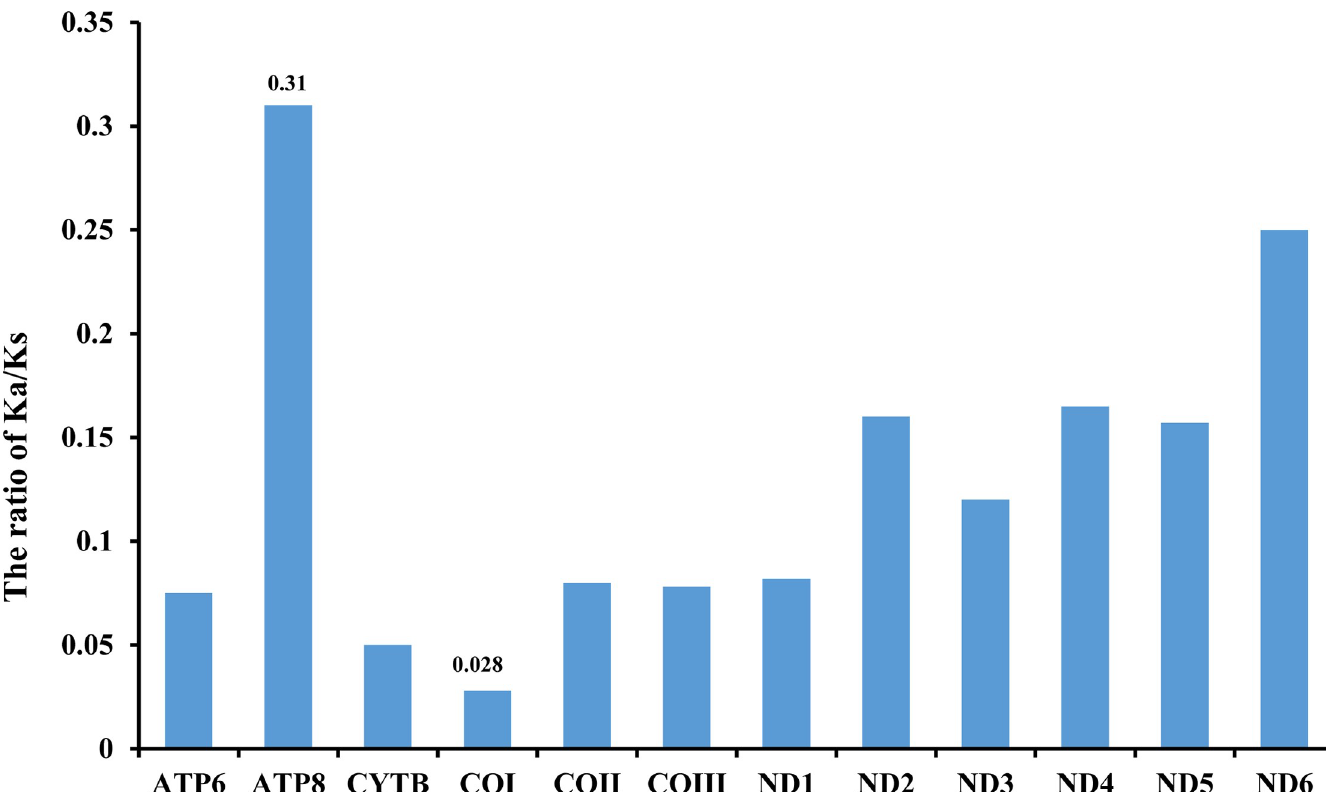
Fig 6. Evolutionary rates of 13 PCGs in the mitogenomes of fifteen Mantodea species. PCGs: protein-coding genes. The ratio of Ka/Ks (Ks: synonymous nucleotide substitutions; Ka: nonsynonymous nucleotide substitutions).